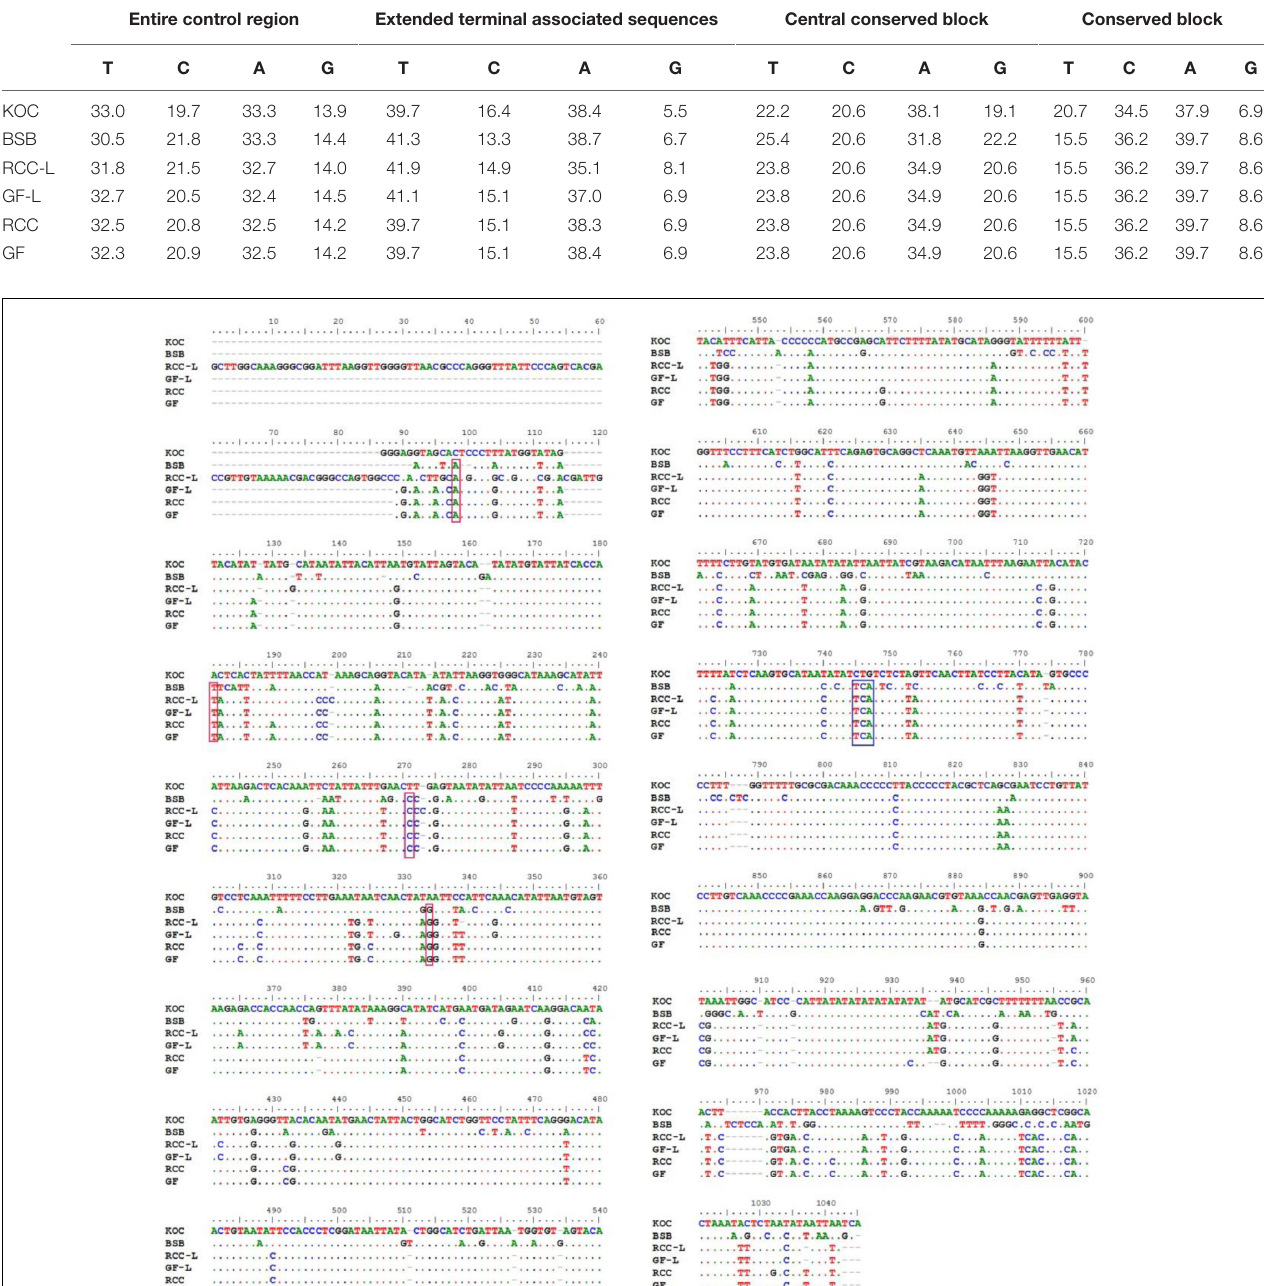
TABLE 1 | Average base composition (%) of the complete mtDNA control region, as well as the three domains within the control region, in KOC, BSB, RCC-L, GF-L, RCC, and GF.